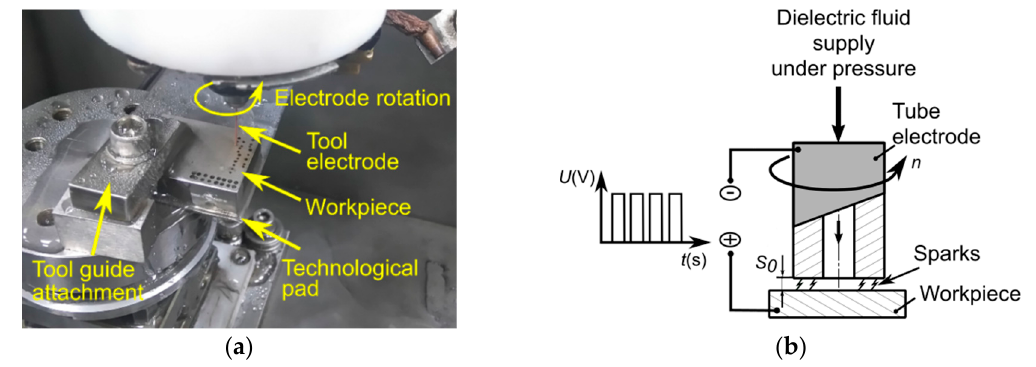
Figure 4. ( a ) A photograph of the experimental setup; ( b ) the scheme of the electrical discharge drilling process.